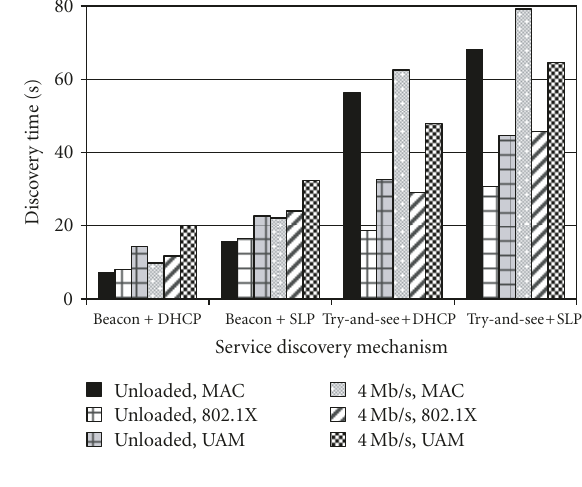
Figure 9: Colour printing: service discovery times. Figure 10: B/W printing: service discovery times.